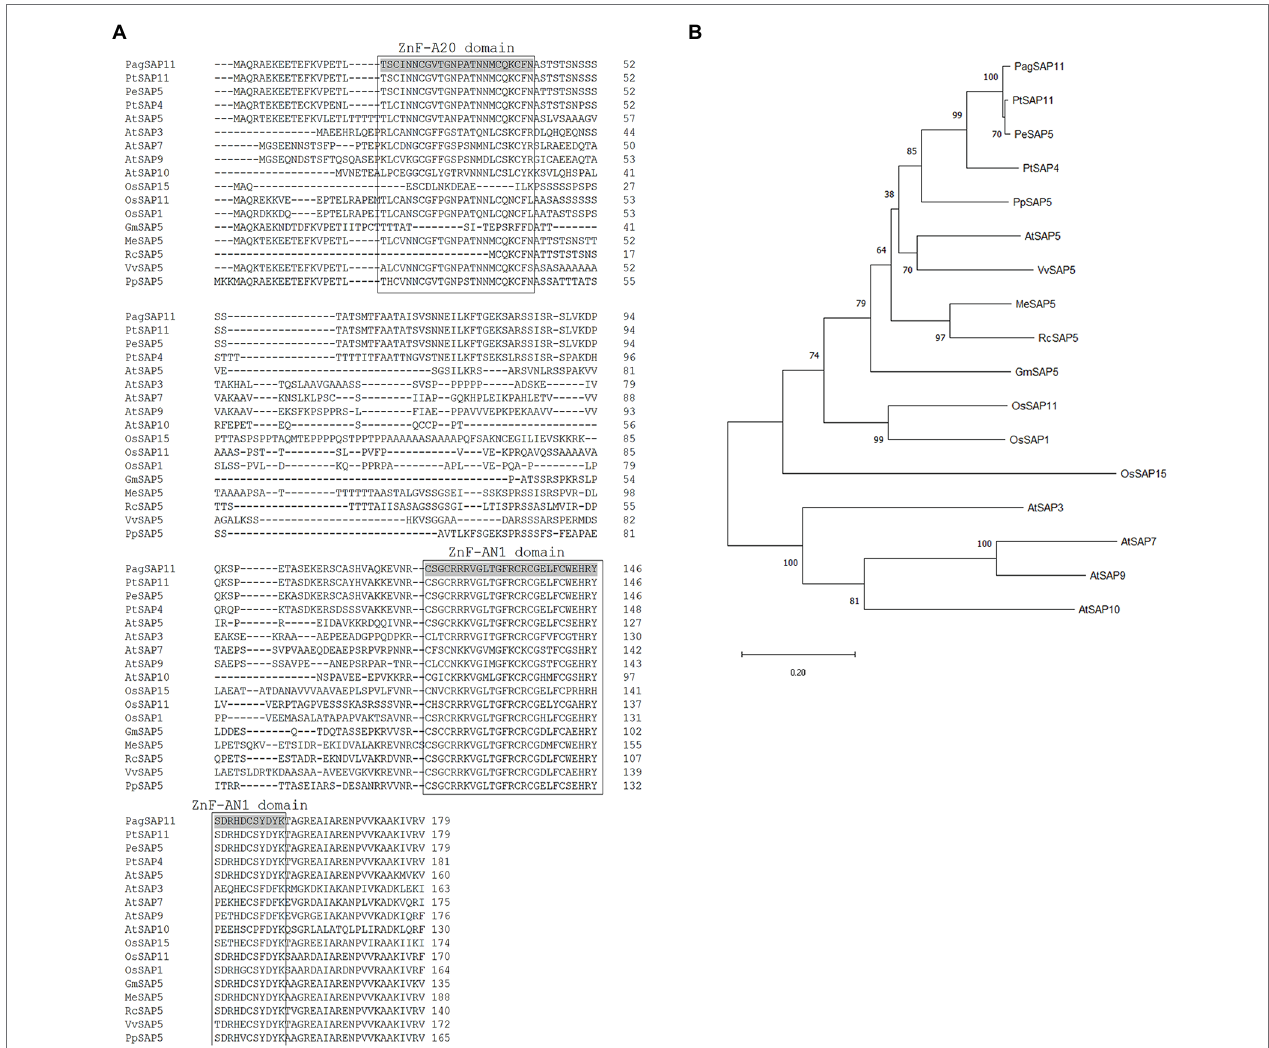
FIGURE 1 | Comparison of the predicted protein sequences of PagSAP11 with other plant SAP proteins. (A) Multiple sequence alignment of PagSAP11 and related proteins from Populus trichocarpa , Populus euphratica , Arabidopsis thaliana , Oryza sativa , Glycine max , Manihot esculenta , Ricinus communis , Vitis vinifera, and Prunus persica . (B) Phylogenetic analysis of proteins from (A) .